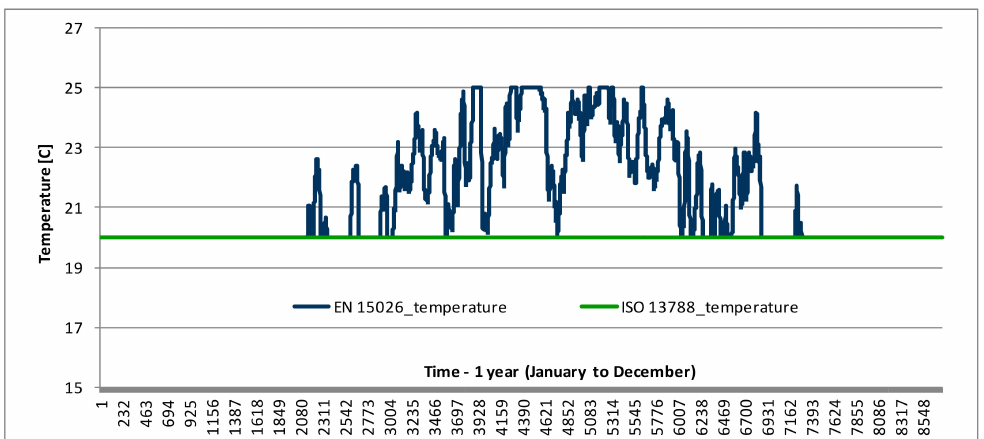
Figure 4. Indoor air temperature according to standards ISO 13788 and EN